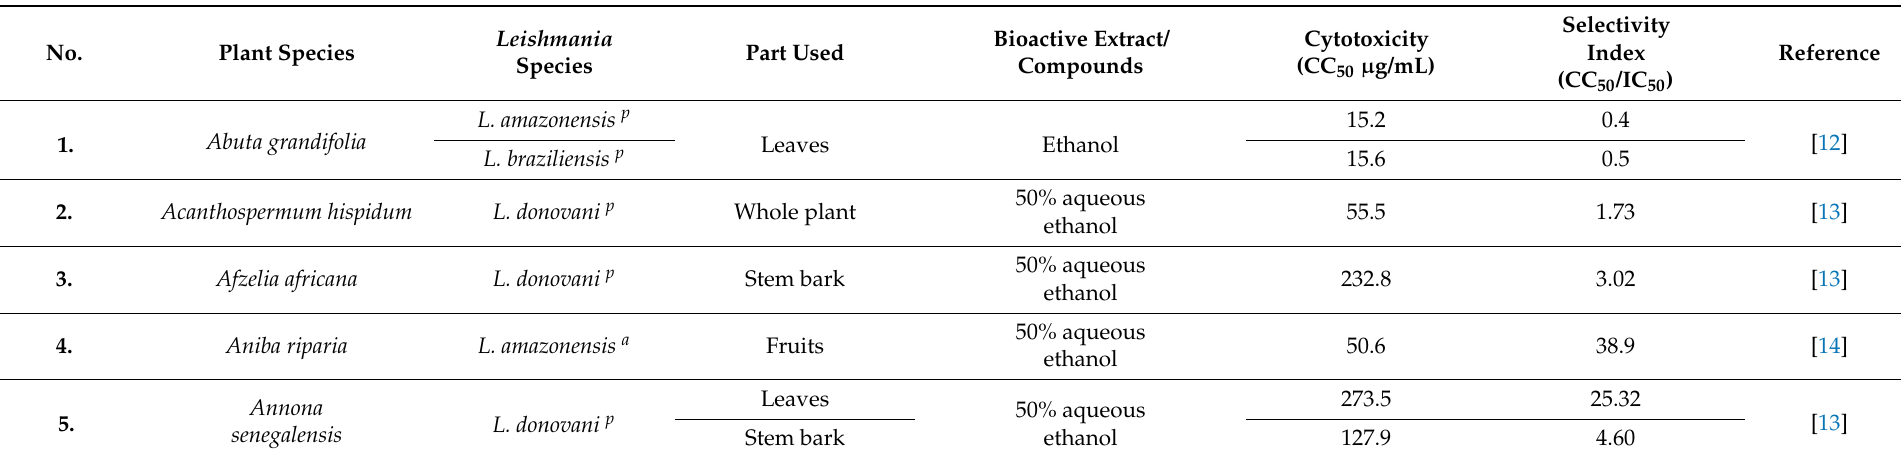
Table 5. Cytotoxic activity and selectivity index of medicinal plants in the present study ( p = promastigote; a =